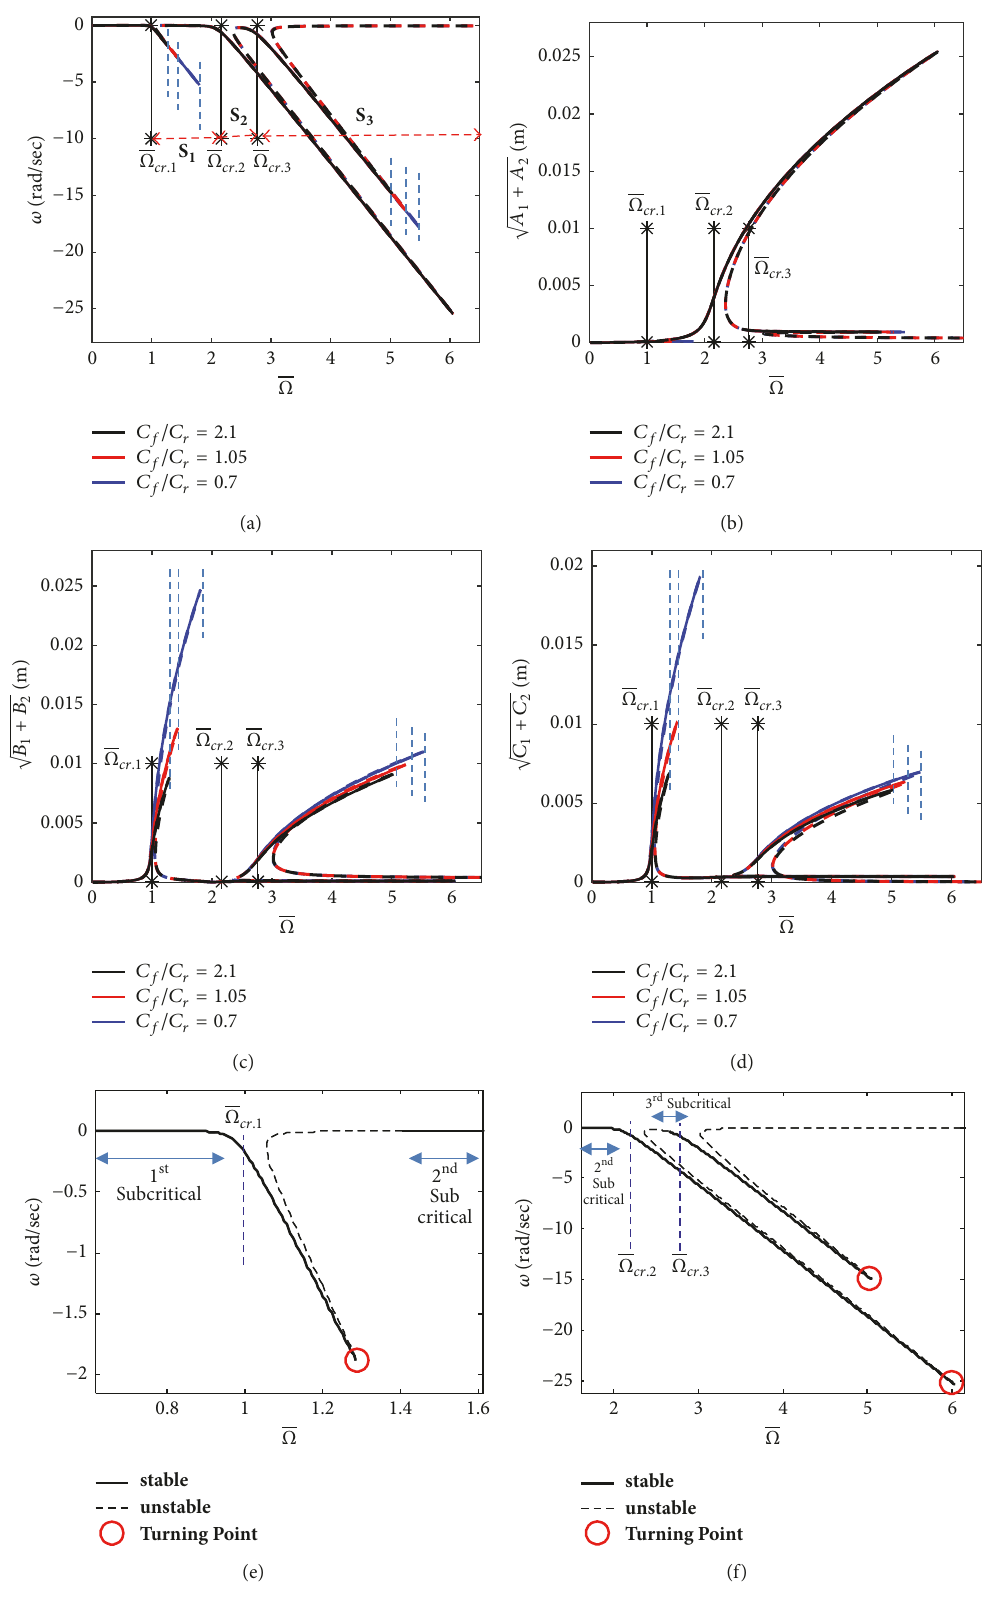
Figure 8: Effect of damping ratio 𝐶 𝑓 /𝐶 𝑟 and rotor speed ratio Ω for limit cycle